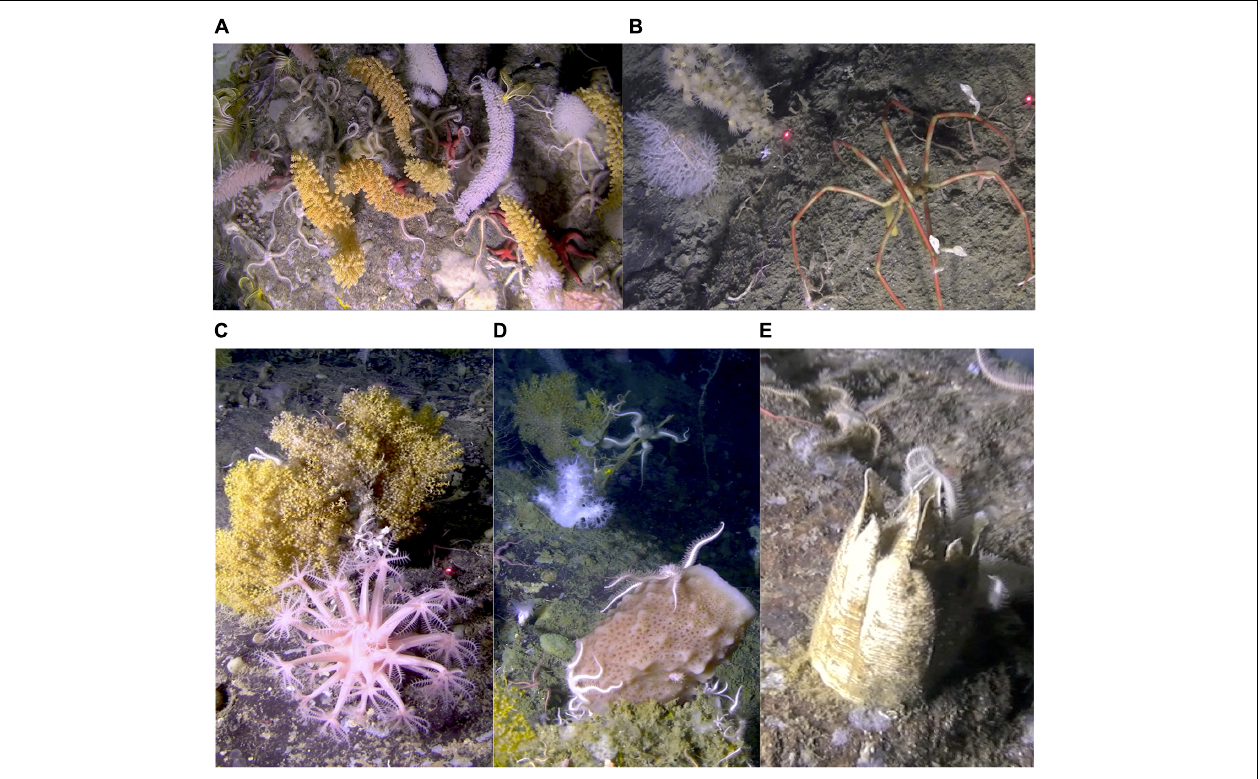
FIGURE 12 | VME off Lecointe Island, Gerlache Strait (Dive 7). (A) Diverse coral assemblage on a boulder ∼ 400 m. Three species of primnoid corals; Thouarella cf. grandiflora (orange), T . cf. variablis (white bottle brush) and Dasystenella cf. acanthine (pink). White isidid (bamboo) corals, Primnoisis sp., to the right of the image. Also seen is a small white Gersemia soft coral, upper center. (B) Bamboo coral, like this Primnoisis sp. (white) are notably abundant off Lecointe Island. Zoanthids were only observed at this site; this species, Parazoanthus sp., parasitizes other corals. Lasers 20 cm apart. (C) Yellow Acanthogorgia sp. and Acanthomastus spp. soft coral. (D) Stony scleractinian corals and in the foreground is a brown hexactinellid sponge. (E) A large sessile barnacle, probably Bathylasma sp., measures > 10 cm